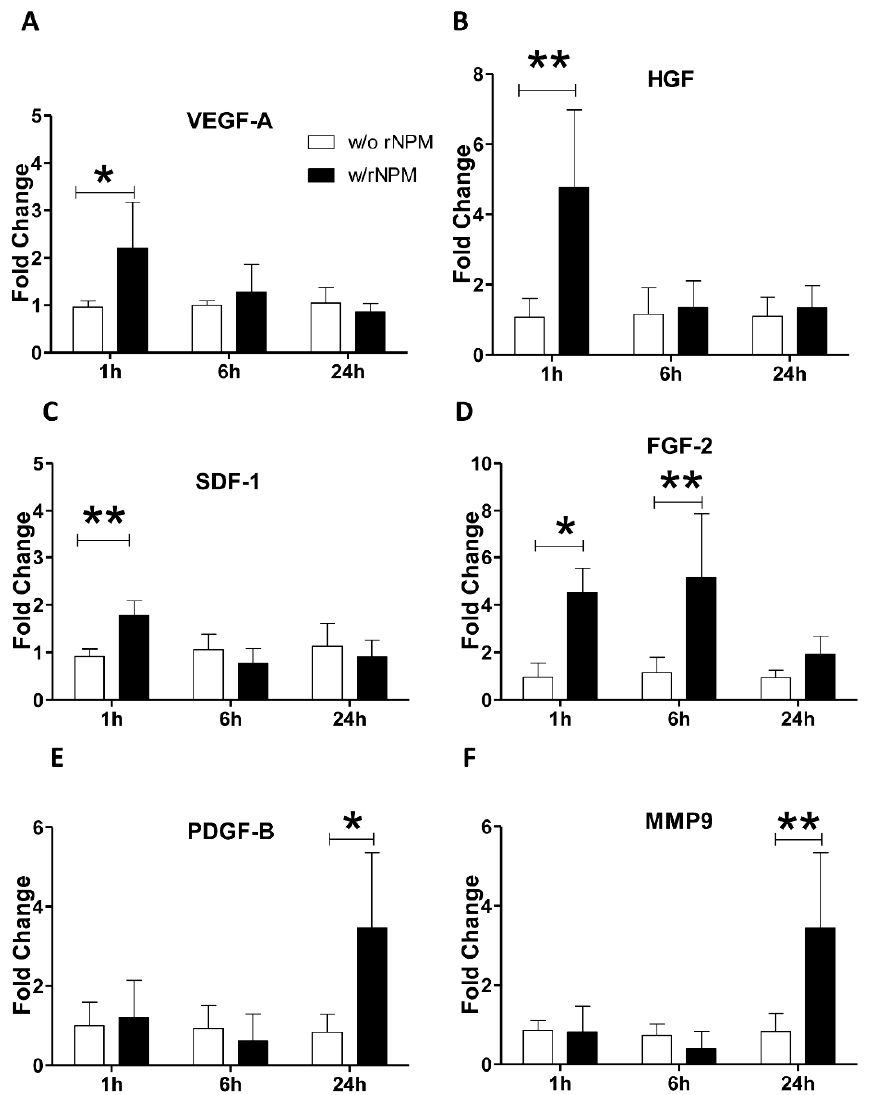
Figure 5. ( A – F ). Gene expression regulation of angiogenic genes. ( A ) The graph shows the upregula- tion of mRNA levels of: ( A ) VEGF-A , ( B ) HGF , ( C ) SDF-1 , ( D ) FGF-2 , ( E ) PDGF-B , ( F ) MMP9 after 1, 6, or 24 h of stimulation with rNPM (200 ng/mL, w/rNPM) compared to the untreated control (w/o rNPM). Data are the results of 3 independent experiments (technical triplicates). * p < 0.05, ** p < 0.01).